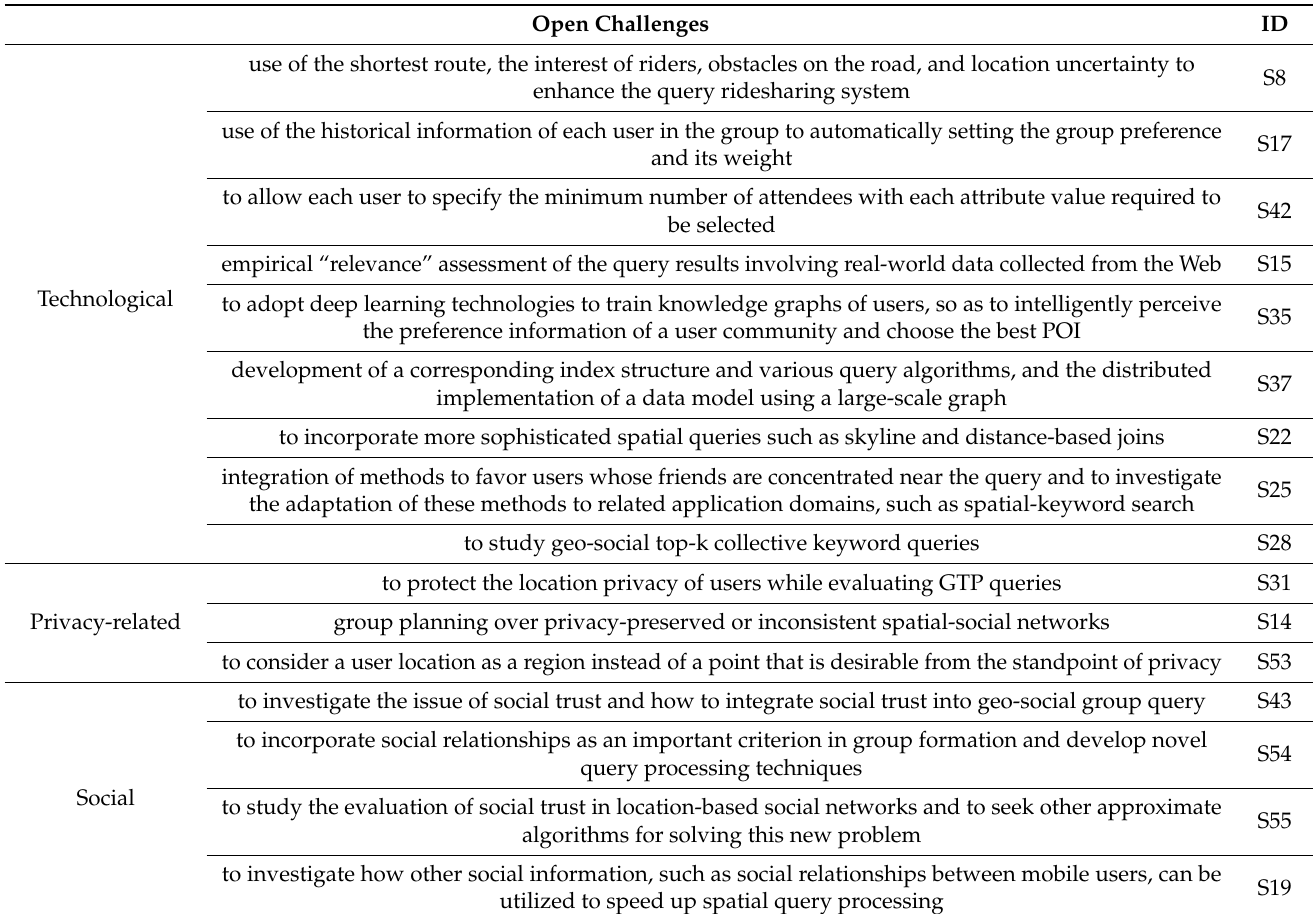
Table 20. Open challenges envisaged by the selected